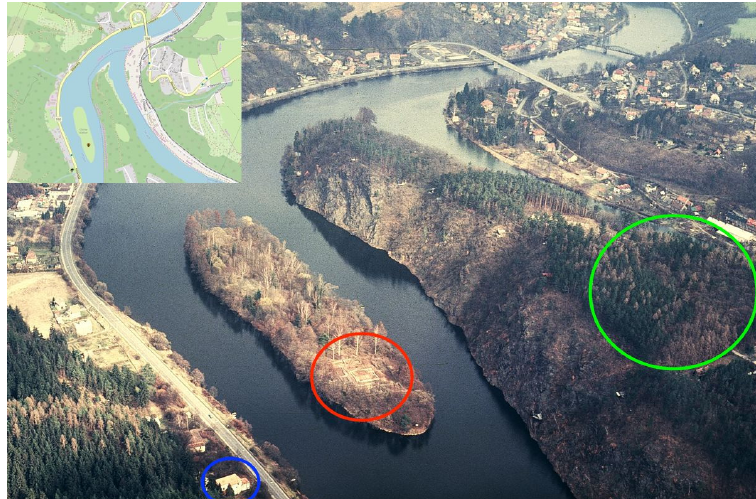
Figure 1. The contemporary state from an aerial view (archeologickyatlas.cz) with marked locations of the lost monastery (red circle), medieval town (green circle), and Church of St. Kilián (blue circle). Source: The Archeology atlas of Czechia (2020; http: // www.archeologickyatlas.cz / cs / lokace / davle_pz_ mestecko_sekanka) and Open Street Map (2020; geo: 49.8812,